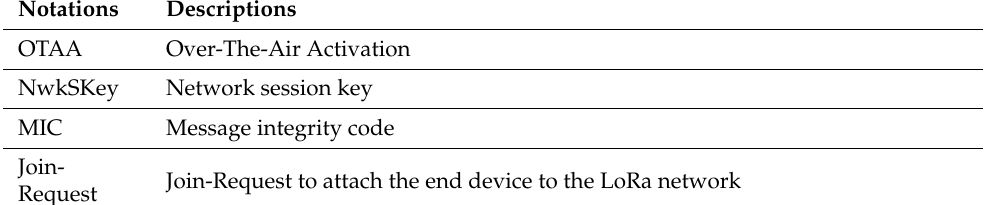
Table 2. The system abbreviations and